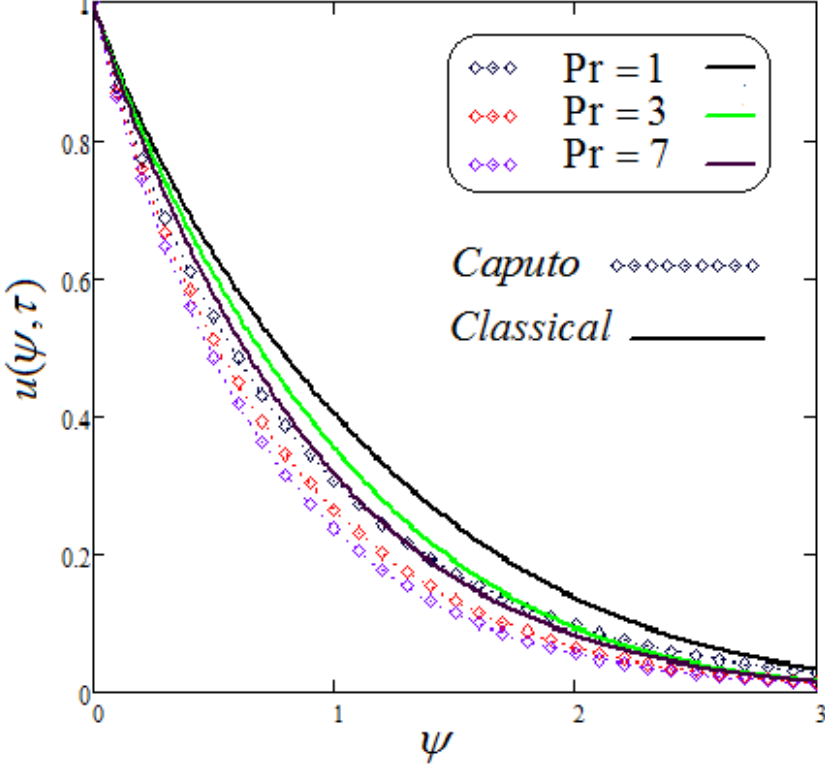
Figure 14. Trace of velocity comparison for dissimilar values of Pr